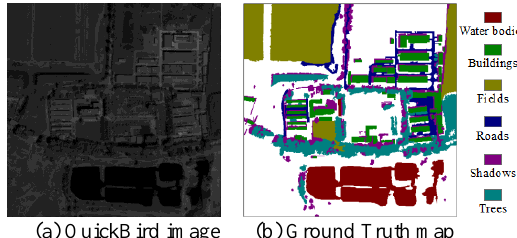
u for different kernel in our i